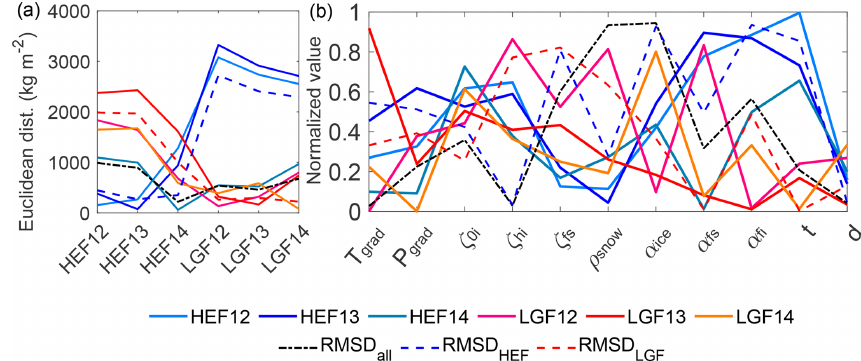
Figure 6. (a) Performance of the single compromise solution for each season and glacier (GGG yy ), with HEF in solid blue colours and LGF in red. The simulations which perform best over a 3-year (RMSD HEF and RMSD LGF ) and 6-year period (RMSD all ) are given with dashed lines, following the same colour scheme. (b) The corresponding parameter setting of the optimal solutions to the left. The colour scheme is equivalent. The compromise solutions for the individual years show different parameter settings and also varying performance out of the calibration period. Only the snow-albedo related parameters show a trend as they take rather large values on HEF and small on LGF. No clear trend is visible for the other